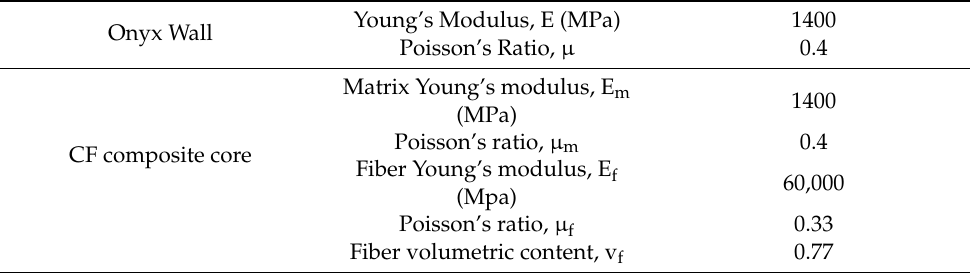
Table 4. Static analysis—material properties